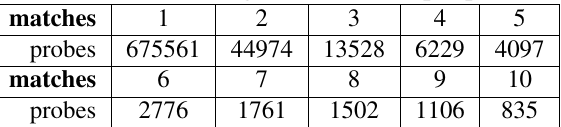
Table 2: Number of genome matches per probe